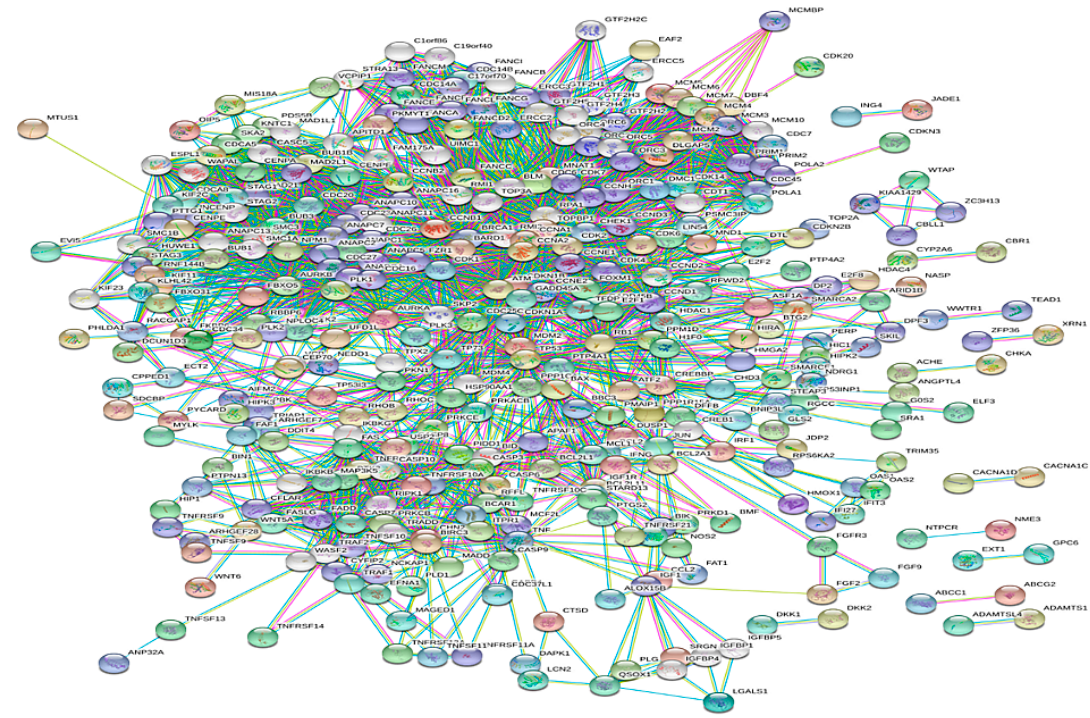
Figure 2. STRING generated NNK rewired protein–protein interaction network with 534 nodes and 2909 edges.